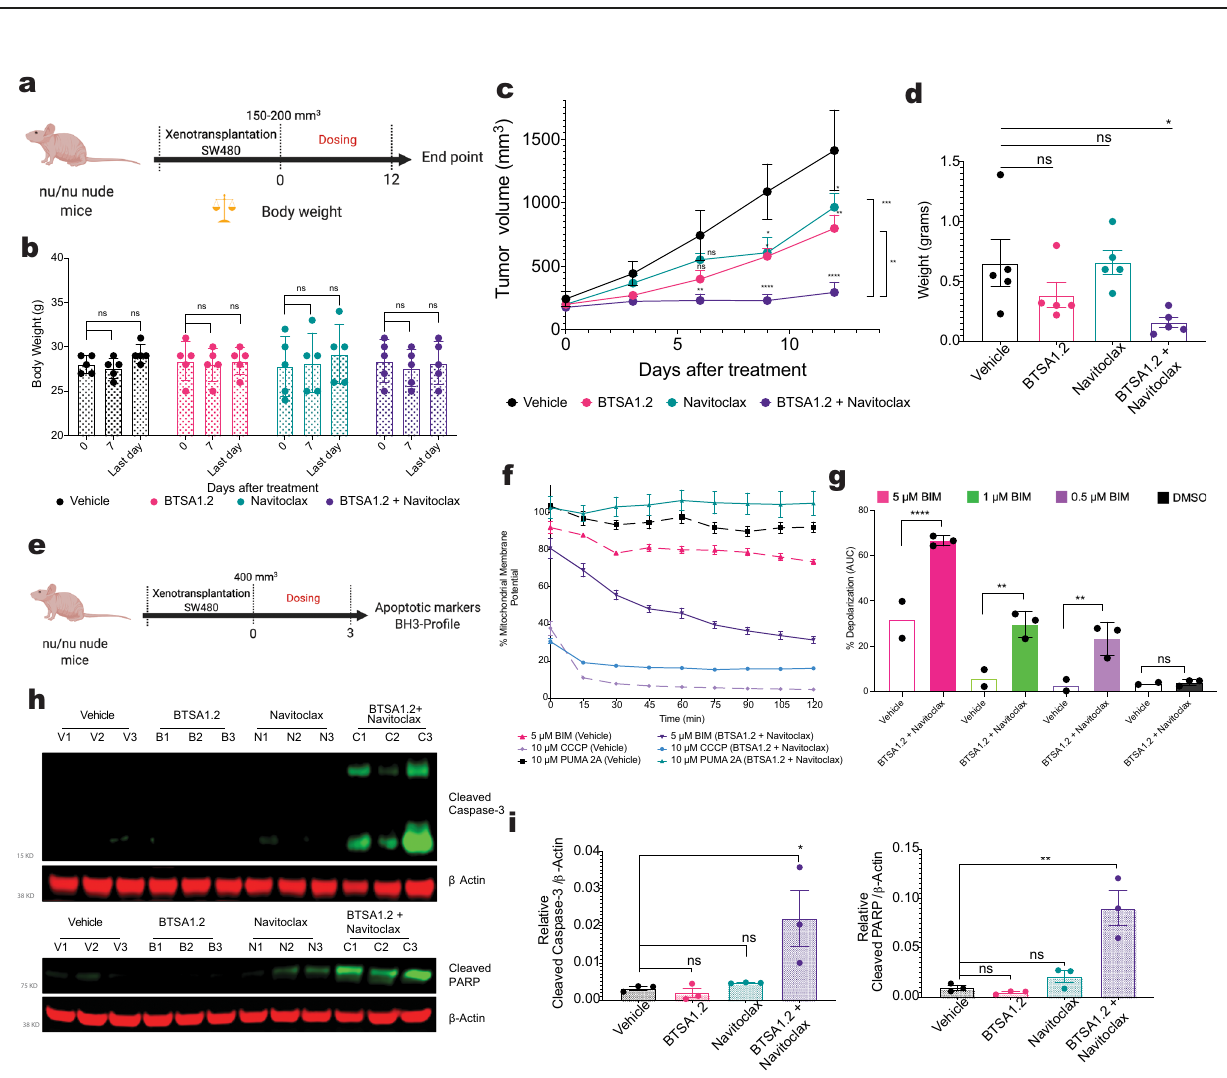
Fig. 4 Combination of BTSA1.2 and Navitoclax is well tolerated and does not enhance Navitoclax driven toxicity in the hematopoietic system. a Schematic of BTSA1.2 and Navitoclax combination toxicity study. b Body weight measurements of CD1-IGS mice at 0, 3, 7, 11, and 14 days after the fi rst treatment with vehicle, 100 mg/kg Navitoclax, 200 mg/kg BTSA1.2 or the combination. c – f Counts of peripheral c , red blood cells; d white blood cells; e lymphocytes; and f platelets in CD1-IGS mice treated with vehicle, 100 mg/kg Navitoclax, 200 mg/kg BTSA1.2 or the combination at 1 and 7 days after treatment. Normal blood counts range for CD-IGS male mice are indicated in gray. Data in b – f , represent mean ± SD from n = 5 mice (Vehicle, BTSA1.2 and Navitoclax) or n = 6 mice (Combination). Statistics were obtained using one-way ANOVA: * p < 0.05; ** p < 0.01; *** p < 0.001; **** p < 0.0001. g Representative tissue sections heart, liver, spleen, bone marrow, brain, lung, and kidney using Hematoxylin and Eosin (H&E) staining from mice after treatment of vehicle, 100 mg/kg Navitoclax, 200 mg/kg BTSA1.2 or the combination. Scale bars, 100 μ m. Data is representative of n = 3 independent samples per group. Source data are provided as a Source Data fi le.